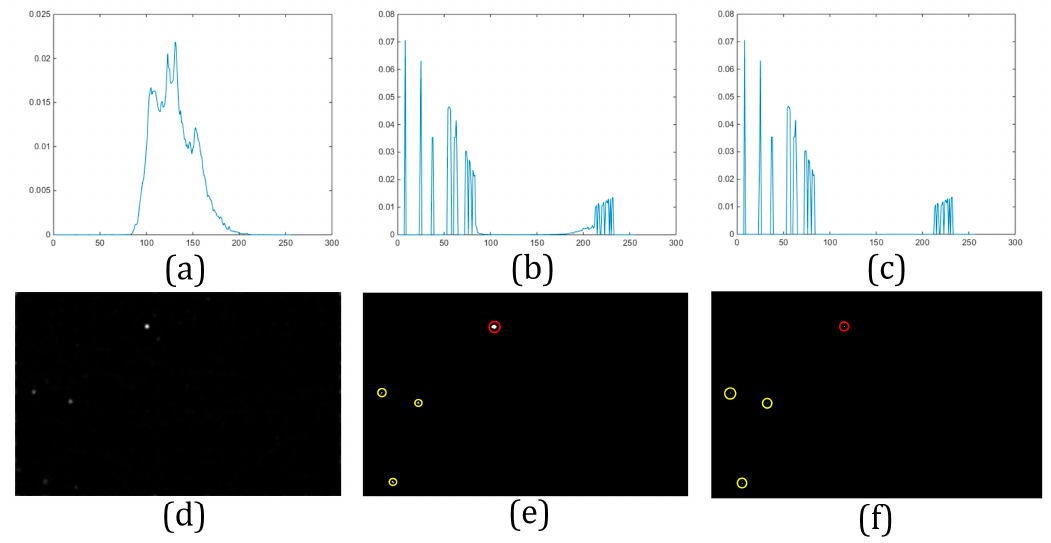
Figure 6. In-frame detection results of Seq.2 generated by our method: ( a ) intensity histogram; ( b ) original saliency histogram; ( c ) modified saliency histogram; ( d ) saliency map; ( e ) binarized image; ( f ) in-frame detection result.